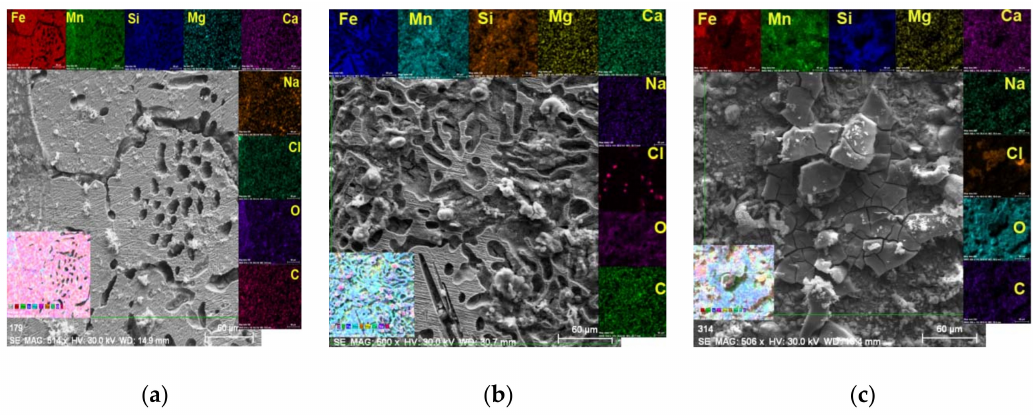
Figure 2. Chemical analysis of the metallic surface after a 7 ( a ), 14 ( b ), and 30 ( c ) days immersion